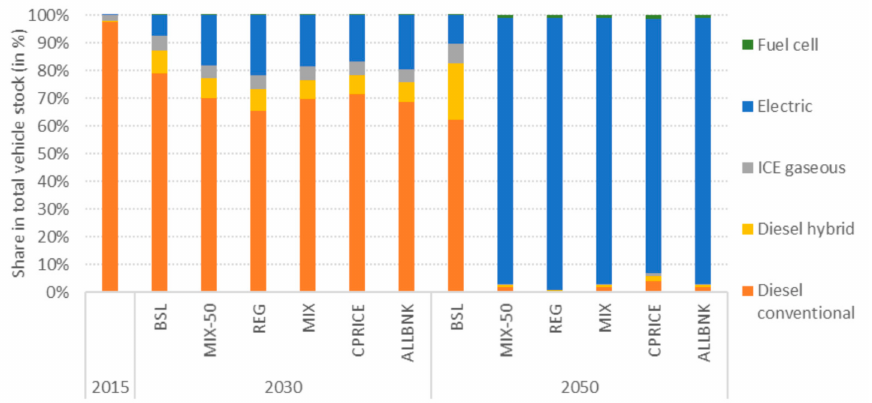
Figure 1. Shares in the bus vehicle stock by type of drivetrain in 2030 and 2050 [49]. BSL—(Baseline scenario) achieving the existing 2030 GHG emissions, renewables and energy efficiency of EU targets. The baseline scenario covers the transport policies adopted up to the end of 2019. MIX-50—An increased ambition scenario to achieve at least 50% GHG reductions. REG—A regulatory-based mea- sures scenario that achieves around 55% of GHG reductions. MIX—Following a combined approach of REG and CPRICE, which achieves around 55% GHG reductions, both by expanding carbon pricing and with ambitious policies that are somewhat lower than those of REG. CPRICE—A carbon-pricing based scenario that achieves around 55% GHG reductions. It assumes the strengthening and further expansion of carbon pricing, via the EU ETS or other instruments, to the transport and buildings sectors, combined with low-intensity transport policies without intensifying energy efficiency and renewables policies. ALLBNK—The most ambitious scenario in GHG emissions reduction, based on MIX and further intensifying fuel mandates for aviation and maritime sectors in a response to an extended scope of GHG reductions covering all aviation and